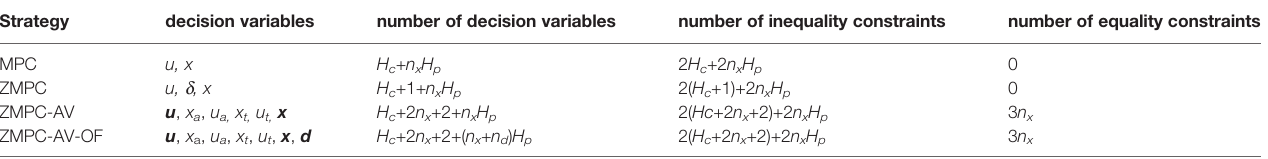
TABLE 2 | Complexity of the MPC strategies. Strategy decision variables number of decision variables number of inequality constraints number of equality constraints